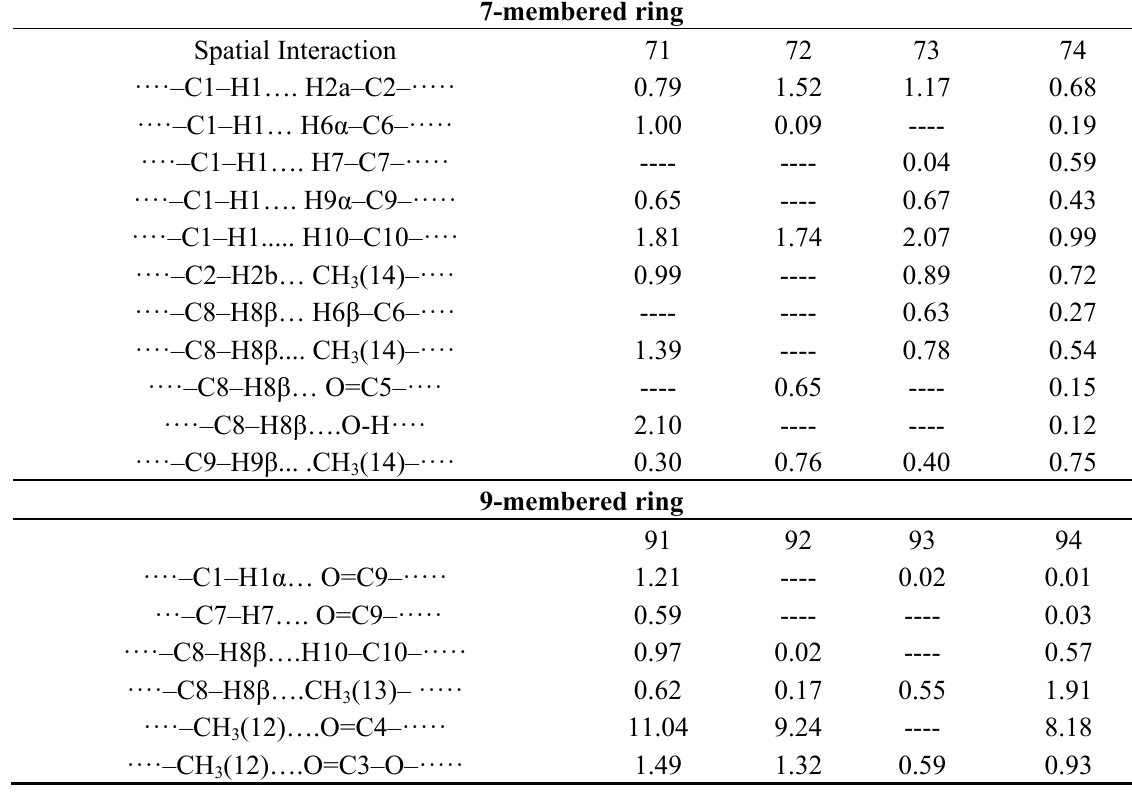
Table 4. NBO Steric Exchange Energies (kcal.mol − 1